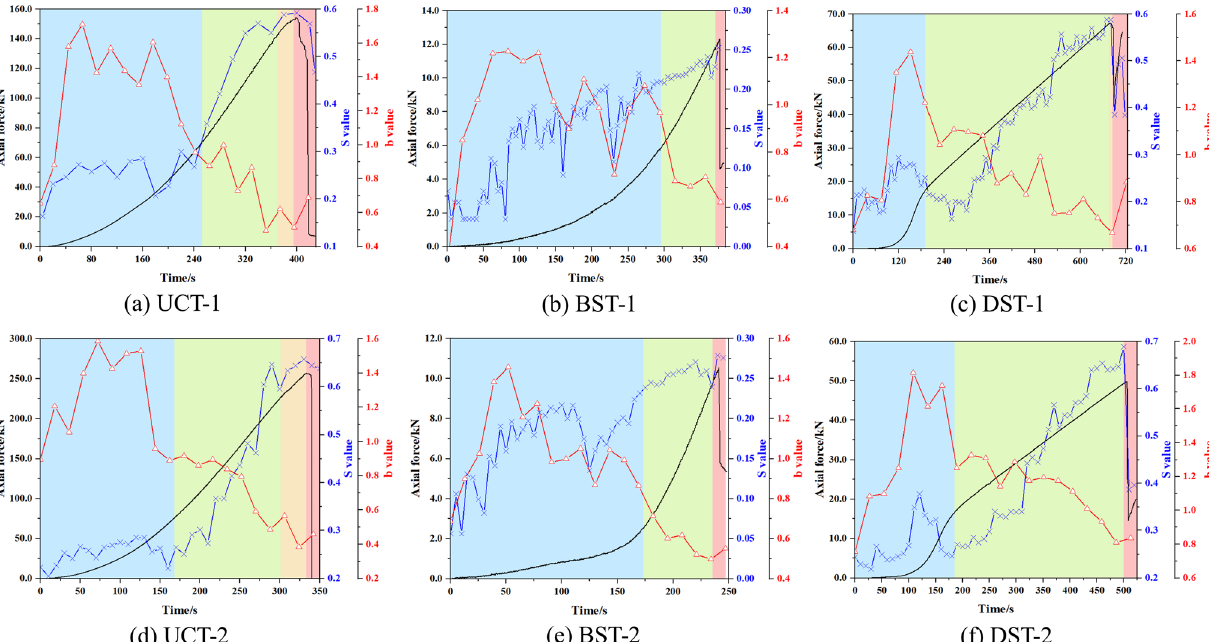
Fig. 4 Evolution curves of AE b and S values: a UCT-1; b BST-1; c DST-1; d UCT-2; e BST-2; f